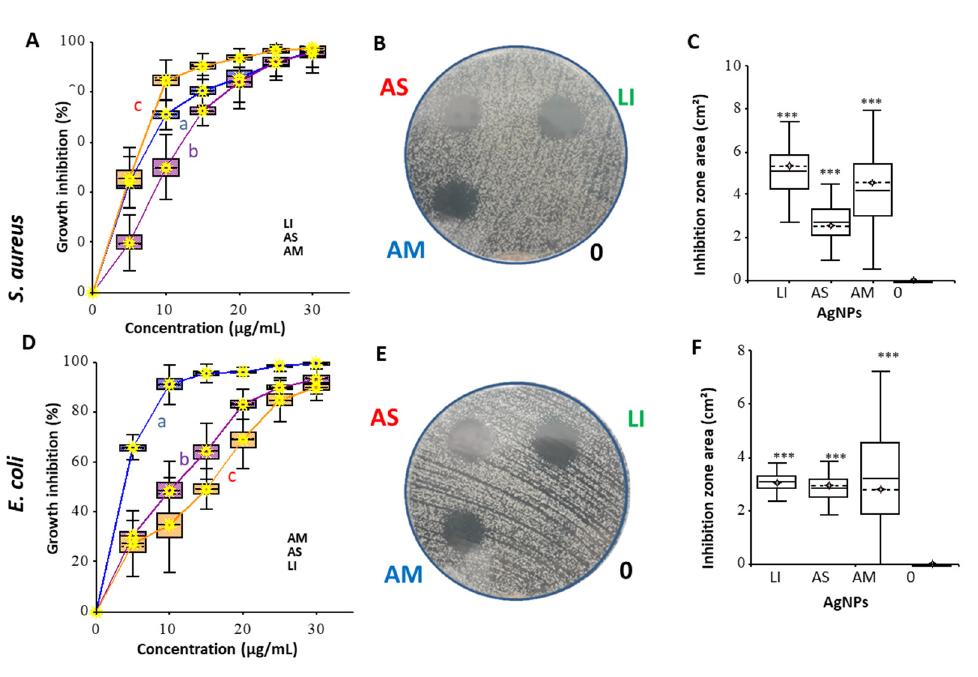
Figure 4. Effect of AgNPs prepared using extracts from L. indica (LI), A. scholaris (AS), and A. multifolium (AM) in liquid medium ( A , D ), in agar diffusion test for different (50, 25, 12.5, 6.25 µ g/mL) concentrations ( B , E ) S. aureus and E. coli cells. Control in the diffusion test was marked as 0. ( C , F ) represent summary data from all performed integrals of inhibition surfaces. All measurements and experiments were performed in no less than five replicates. For further details, see the chapter Material and